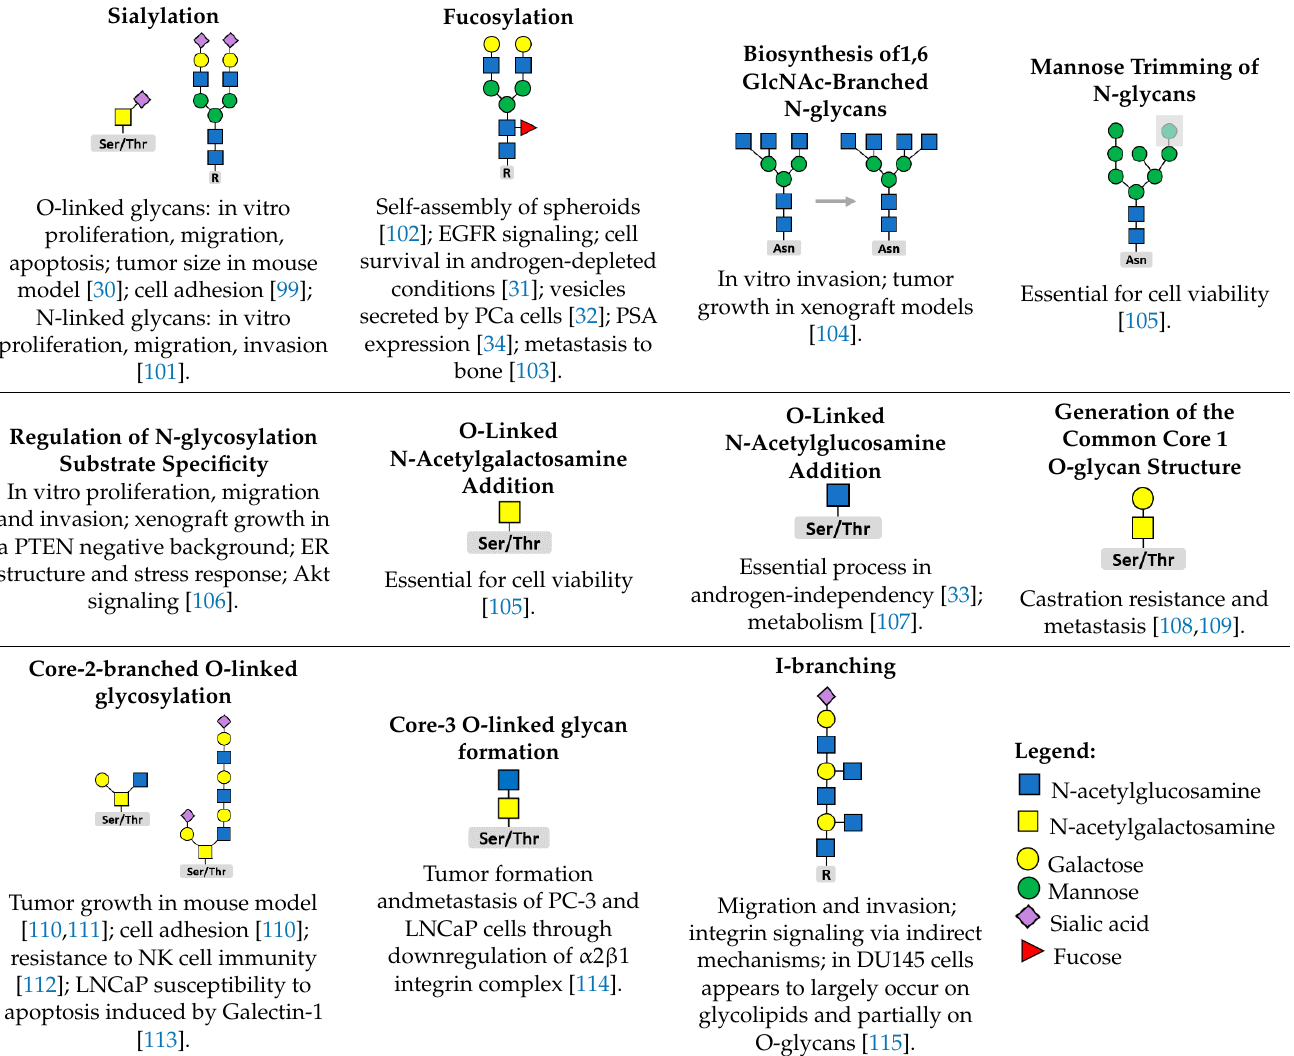
Table 2. Involvement of glycosylation in prostate cancer biology. The step of glycosylation is stated on the top of each rectangle and examples are schematically depicted. The prostate cancer processes affected are listed on the bottom of rectangles.